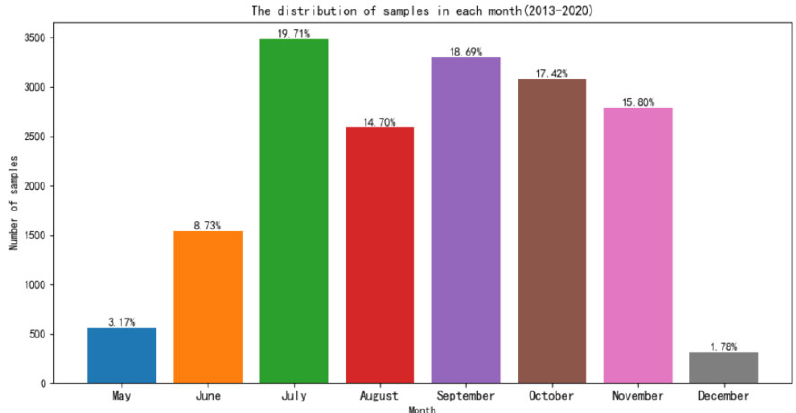
Figure 12. The distribution of CPUE values of fisheries datasets after the dataset’s expansion from approximately 2013 to 2020. As shown in Figure 13, we obtained the correlation of the prediction results of CPUE values and true values of an experiment by using a decision fusion model based on multi ‐ source heterogeneous data feature extraction for generalization experiment. The x ‐ axis in the figure represents the true value of this experiment result, and the y ‐ axis represents the predicted value of this experiment result. If the sample point lies on the y = x function line (red line), it indicates that this predicted value is consistent with its true value, and a sam ‐ ple point below the red line illustrates that the predictive value is lower than the true value. Conversely, it means that the predictive value is higher than the true value. Obvi ‐ ously, for the samples with middle ‐ to ‐ high CPUE values, most of the sample points are below the red line. It illustrates that the uneven distribution of CPUE values affects the training of the model for the samples with medium and high CPUE values. It leads to the poor fitting of the model for the samples of middle and high CPUE values, and its predic ‐ tion results are low.